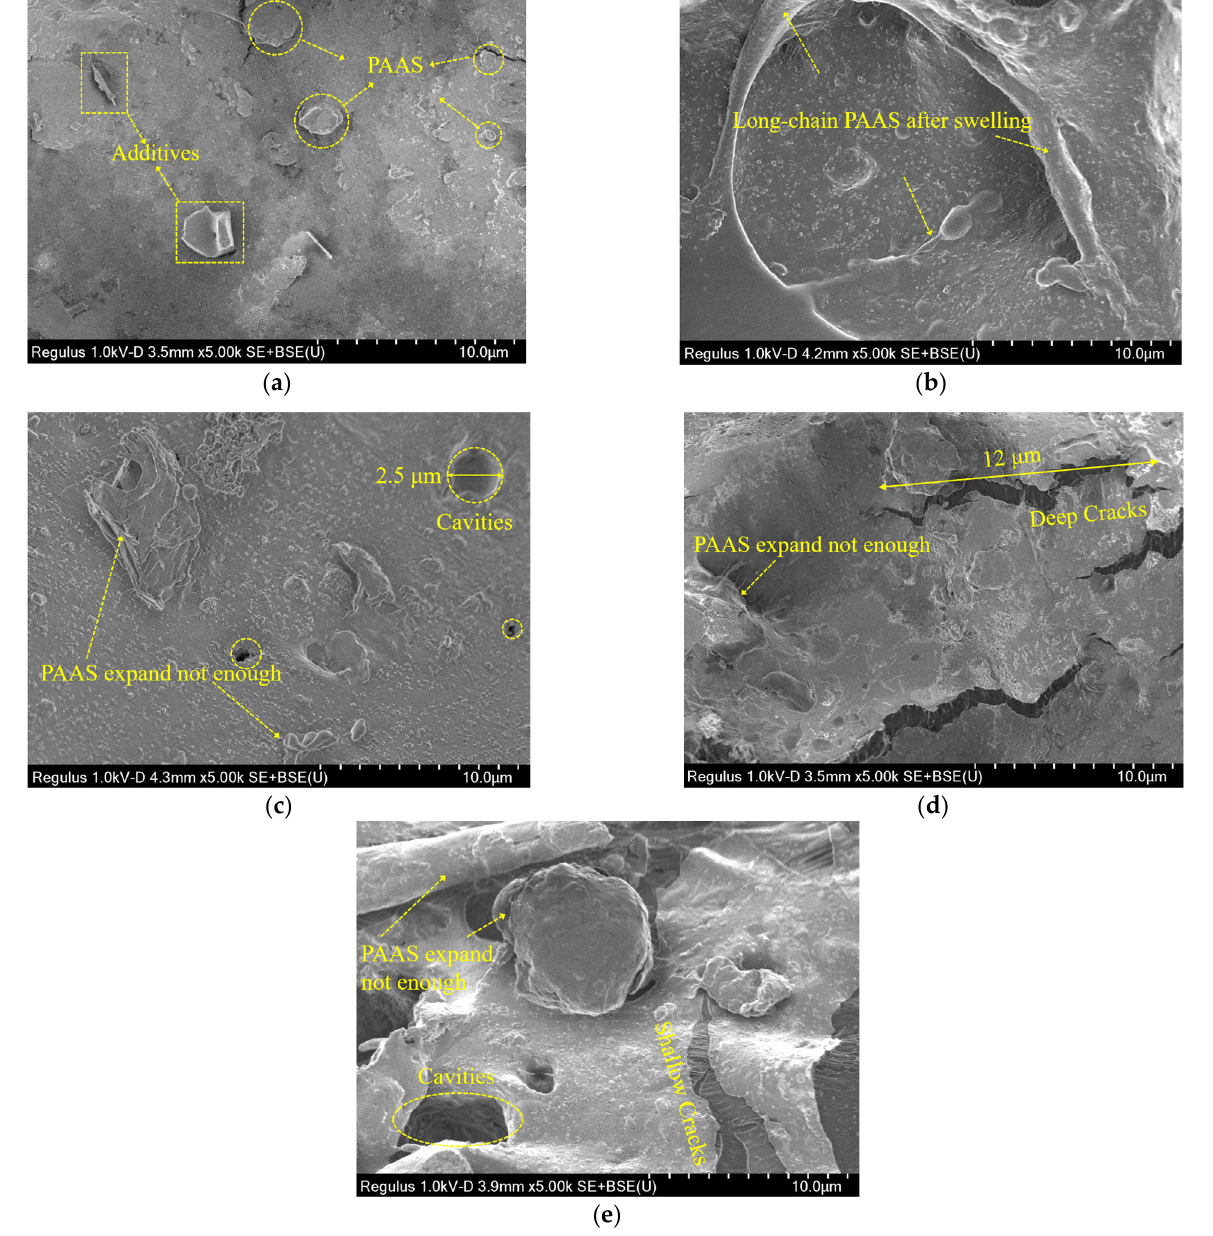
Figure 9. The SEM images of specimens immersed in: ( a ) original specimen, ( b ) the DIW, ( c ) the NaCl solution (100 mM), ( d ) the CaCl 2 solution (100 mM), and ( e ) MSW landfill leachates.